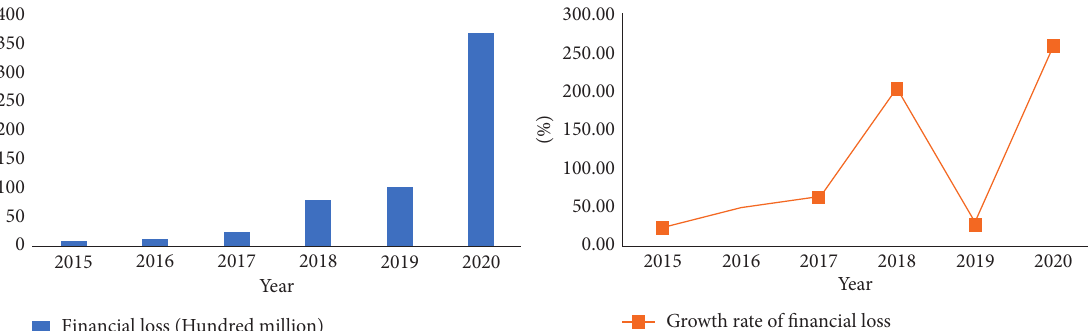
Figure 1: Chart of changes of financial loss and annual growth rate of A-share listed companies from 2015 to 2020.